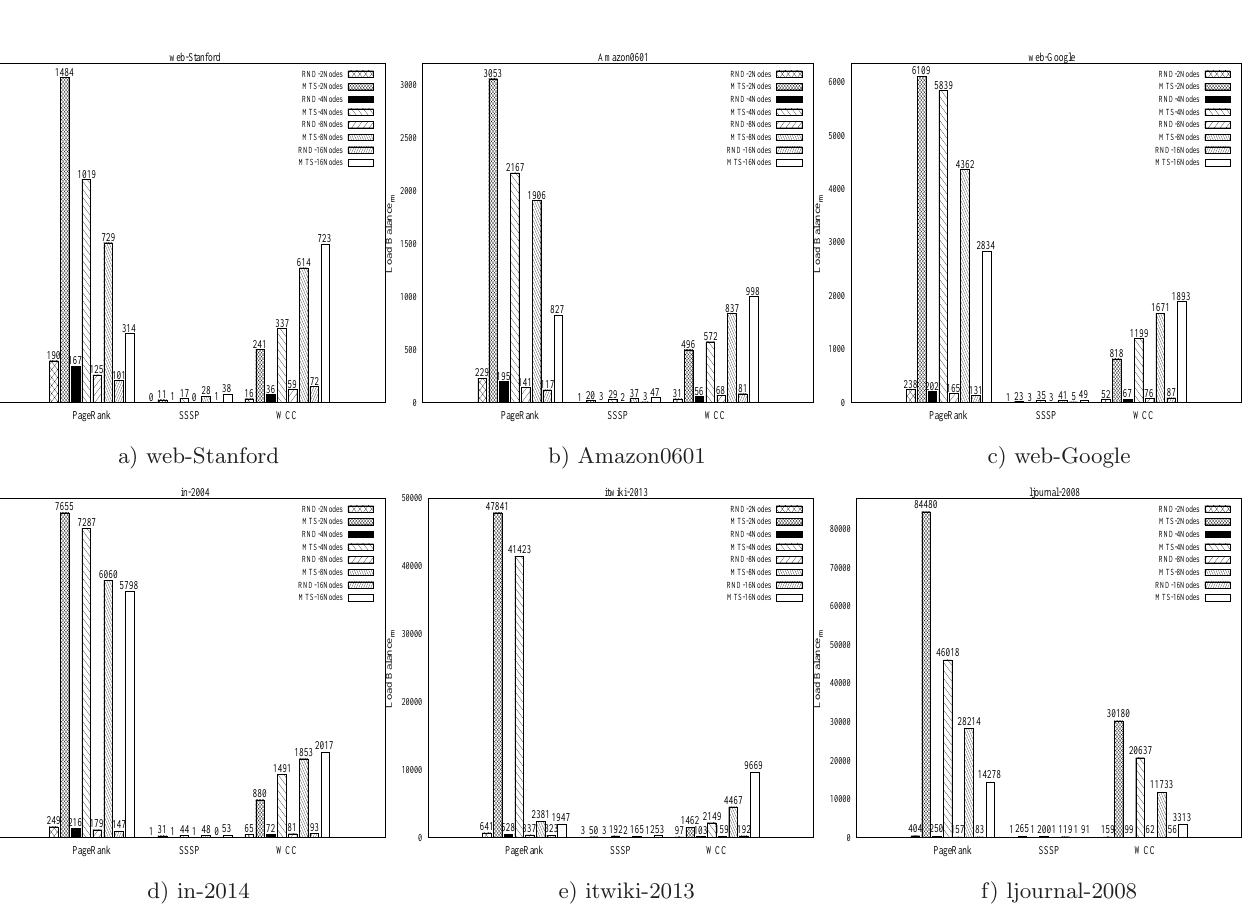
Figure 6. Load Balance rm performance metric for web-Stanford, Amazon0601, web-Google, in-2004, itwiki-2013 and ljournal-2008